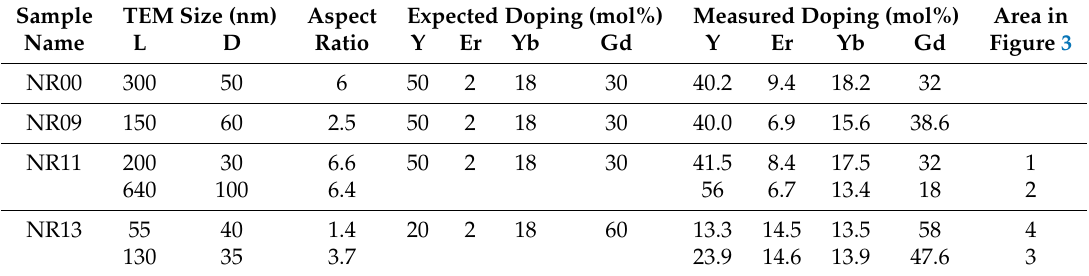
Table 3. Expected and effective doping concentration of different NPs measured by EDX. Two lines in the tabular correspond to two population measured by EDX. The NPs sizes given come from the measured NPs and can differ from the mean